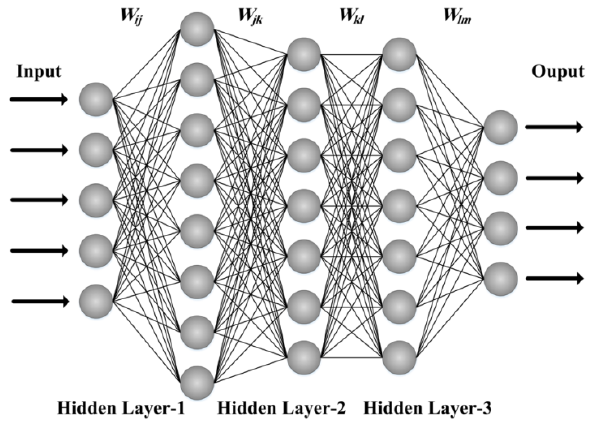
Figure 1. Representation of a basic MLP